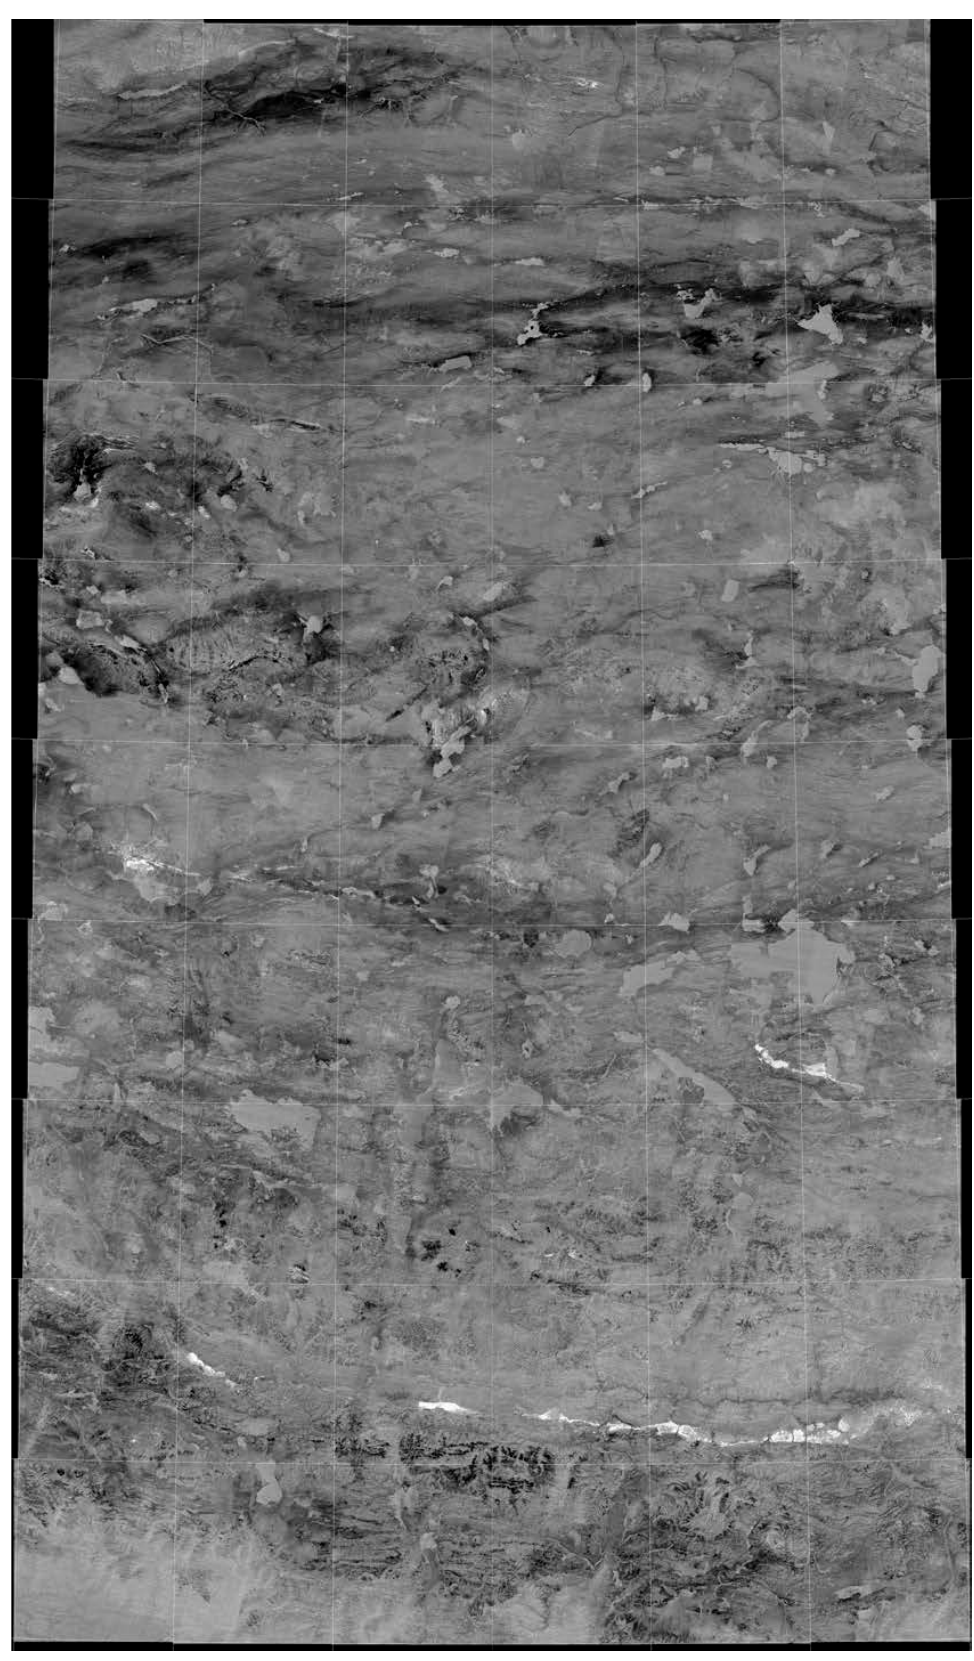
Figure A5. High resolution version of Figure 5c without annotated information.